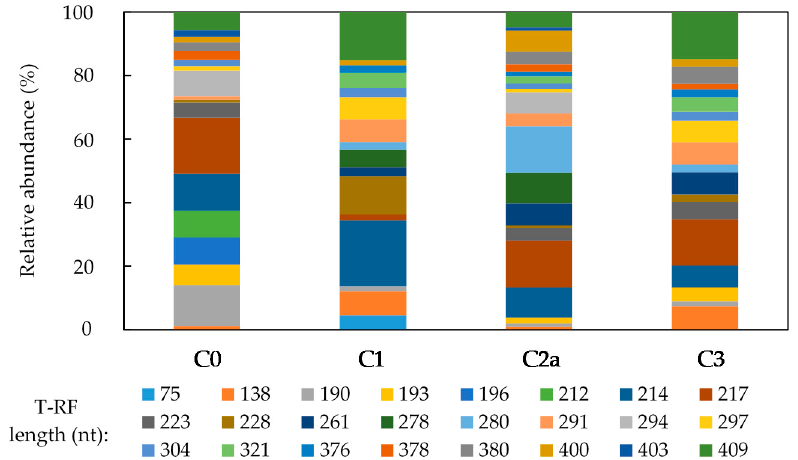
Figure 7. Terminal restriction enzyme fragment length polymorphism (T-RFLP) analysis (HaeIII digests) of amplified 16S rRNA bacterial genes from the biofilm-colonized pebbles collected from the stream (C0) and at different phases (C1, C2a and C3) of operating MnOBs. The T-RFs are stacked upwards in each column in increasing fragment lengths.